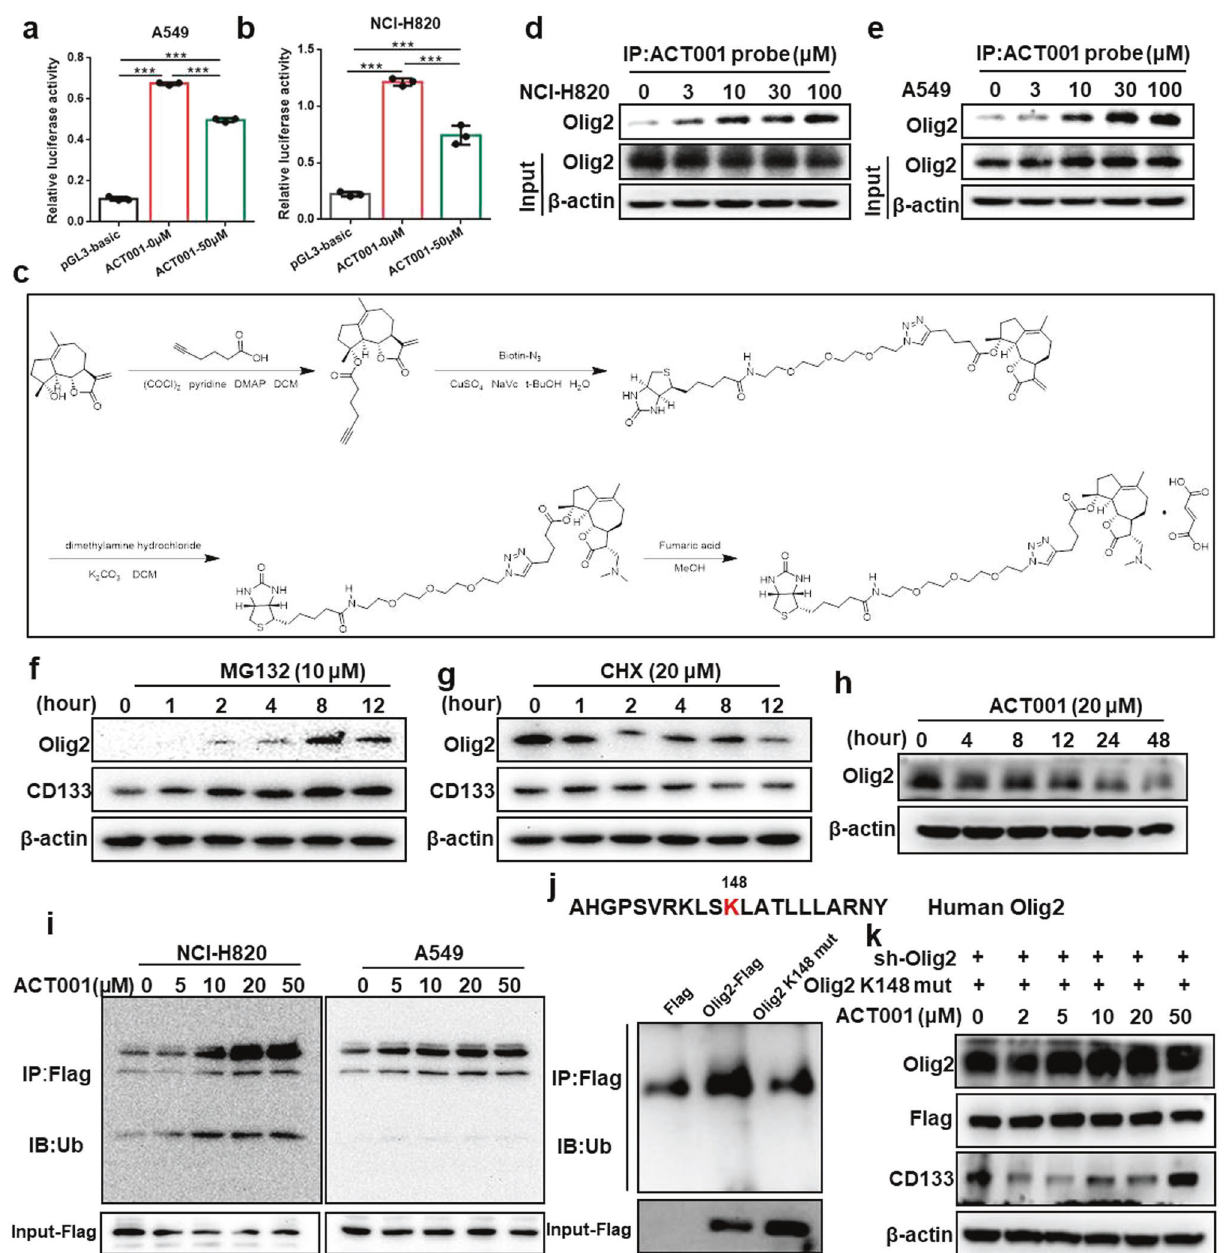
Fig. 6 ACT001 regulated CD133 transcription by promoting Olig2 degradation via ubiquitin proteasome pathway. a , b CD133 promoter activity by dual-luciferase reporter assays after ACT001 treatment for 24 hours in A549 and NCI-H820 cells. c Chemical synthesis schematic of ACT001 biotin coupled probe. d , e A549 and NCI-H820 cell lysates were incubated with ACT001 biotin coupled probe. Then the proteins binding to ACT001 were collected by streptavidin-agarose pull-down and analyzed by western blot assay. f Protein level of Olig2 and CD133 in A549 cells treated with MG-132 (10 μ M) at indicated time intervals. g Protein expression of Olig2 and CD133 in A549 cells treated with cycloheximide (CHX, 20 μ M) at indicated time intervals. h The kinetics of Olig2 level in NCI-H820 cells after ACT001 treatment at indicated time intervals. i The ubiquitylation of Olig2 after treated with ACT001 at different concentrations for 24 hours was determined in A549 and NCI- H820 cells using an anti-Flag antibody after transfected with pCMV-N-Flag-Olig2. j The Olig2 ubiquitination sites were predicted by GPS-Uber and veri fi ed the ubiquitination level was reduced in K148R mutant cells. k CD133 and Olig2 expression were analyzed after treated with ACT001 for 24 hours in K148R mutant cells. The data were presented as the mean ± SD, *** p <